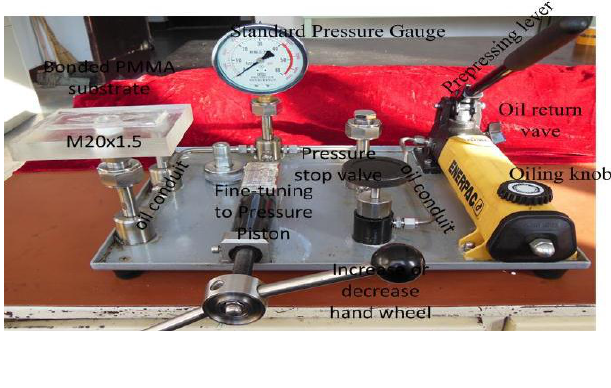
Figure 5. The burst test setup connected with the bonded PMMA substrate.